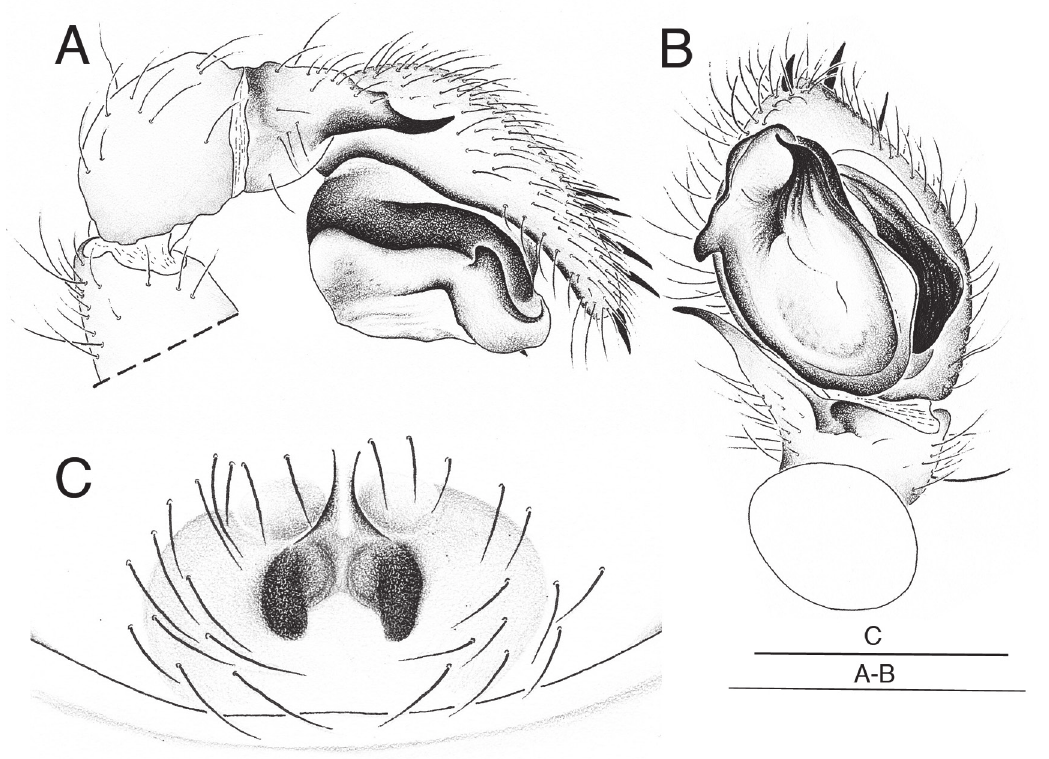
Fig. 5. Palindroma morogorom gen. et s p. nov. A–B. Holotype, ♂. C. Paratype, ♀. A . ♂, palp, retrolateral view. B . Idem, ventral view. C . ♀, epigyne, ventral view. Scale bars: A–B = 1mm, C = 0.5